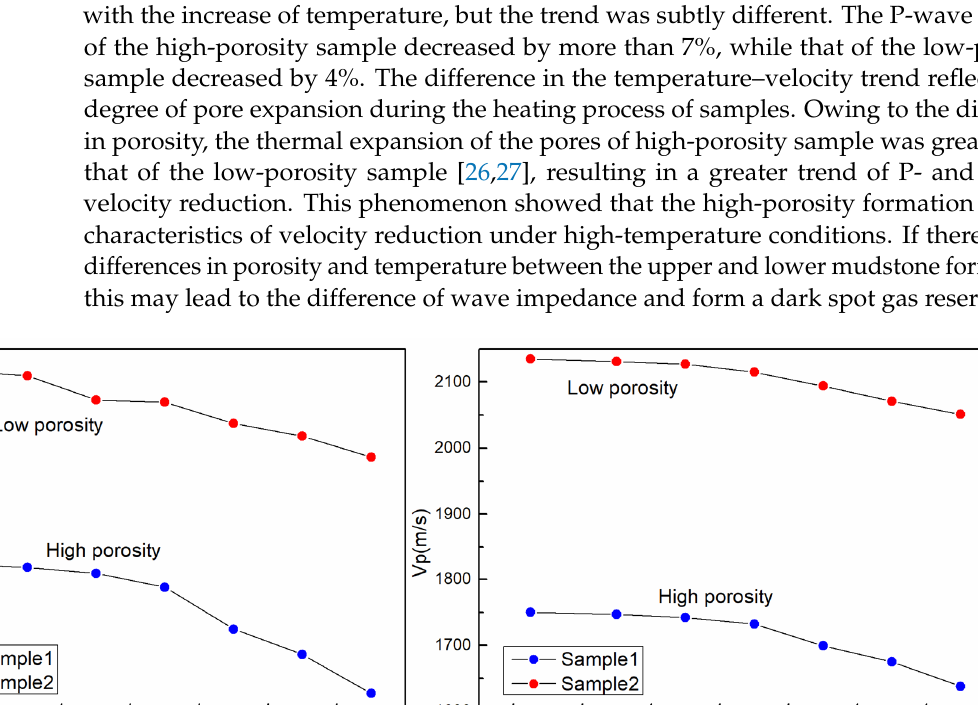
Figure 8. Cross-plot of temperature and P- and S-wave velocity.